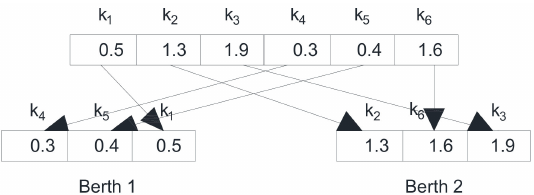
Figure 1. Solution representation of six vessels and two berths